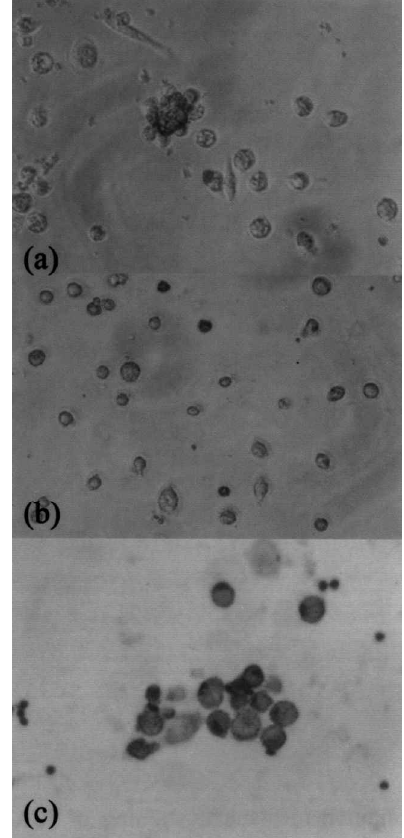
FIG. 4. Aggregation of AM from a patient with pulmonary sarcoidosis, treated with TNF- a (A) or TNF- a anti-ICAM-1 (B) (both ´ 50). Aggregation of AM was abolished by treatment with antibody to ICAM-1. APAAP stains for ICAM-1 on AM treated with TNF- a (C) ( ´ 100). ICAM-1 expression was indicated by strong positivity in the cytoplasm and on the membrane of AM.